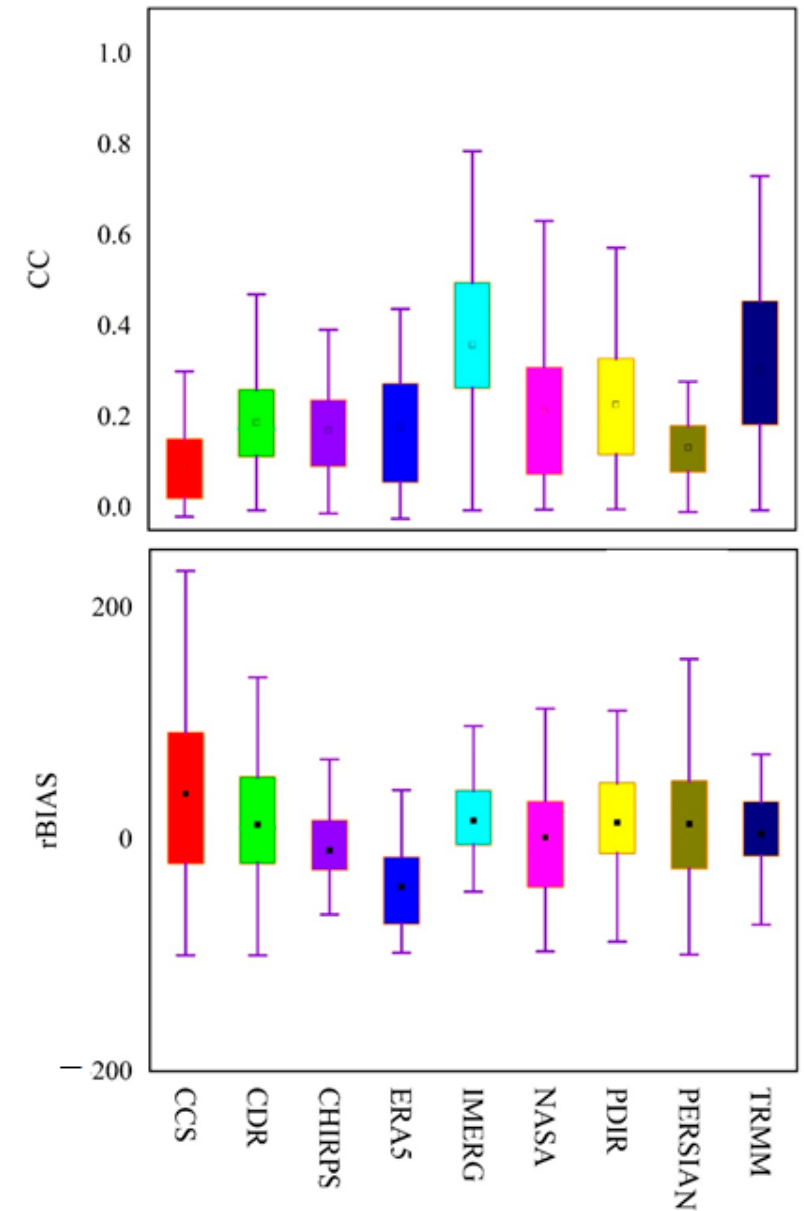
Figure 9. Box plots showing the CC and rBias estimates for the daily reanalysis and SPP (CCS, CDR, CHIRPS, ERA5, IMERG, MEERA2, PDIR, PERSIANN, and TRMM) products against in situ data.